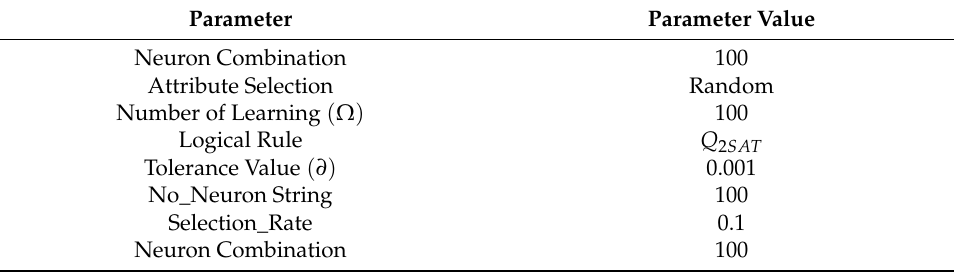
Table 3. List of parameters in E2SATRA [22].